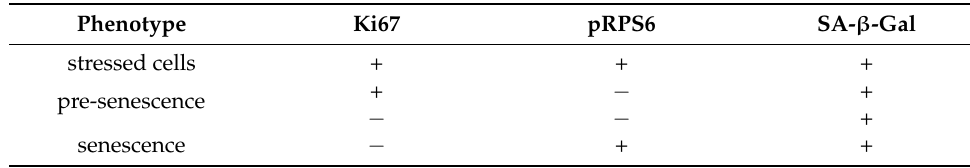
Table 2. Molecular algorithm for identifying cell